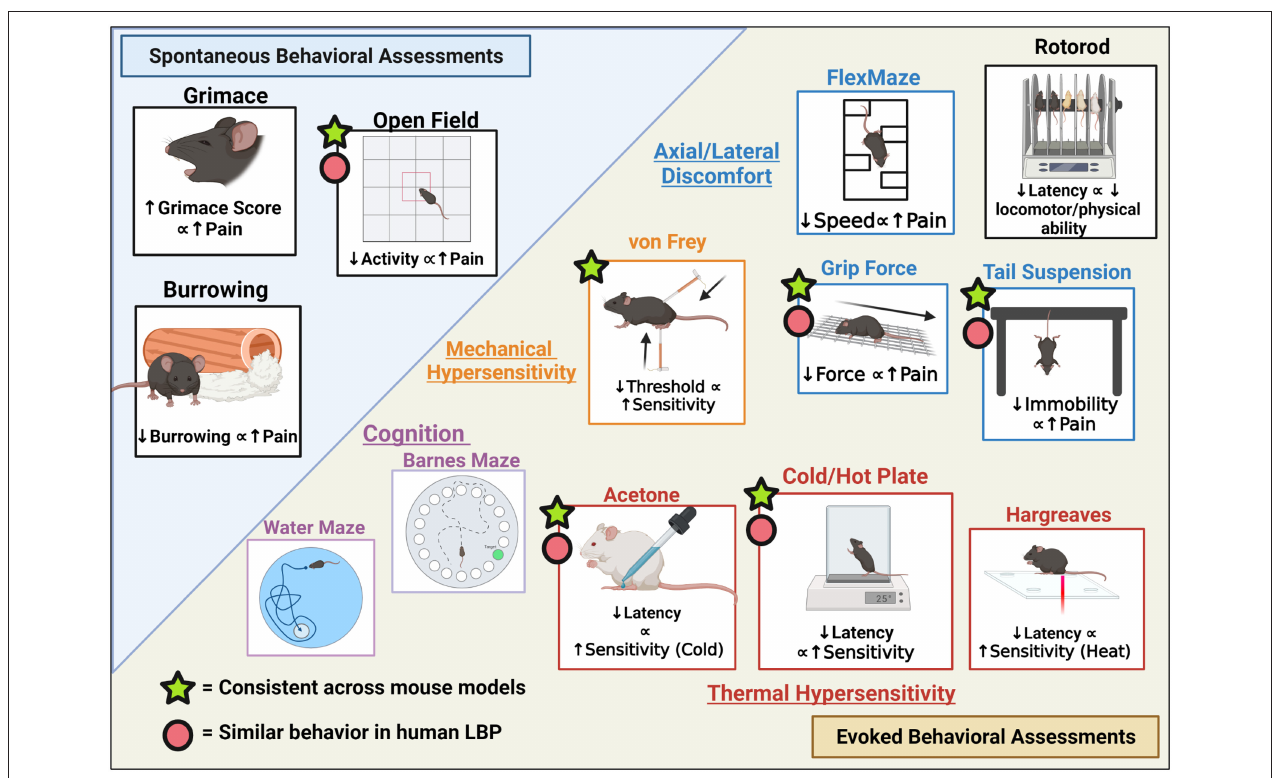
FIGURE 2 | Pain-like Behavioral assessment with relevance to LBP categorized as Spontaneous vs. Evoked behavioral assessments and respective measures. Figure created using